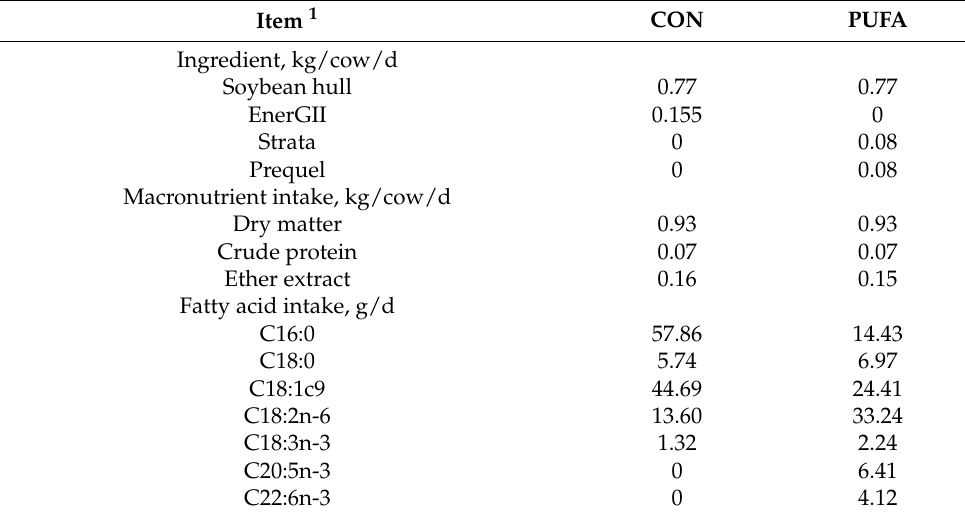
Table 1. Nutritional profile and intake of the supplements that contained soybean hulls with 155. g DM/d EnerGII (CON) or 80 g DM/d Strata + 80 g DM/d Prequel (PUFA) for the last 77 ± 6 d of